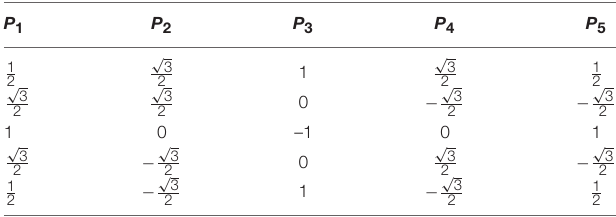
TABLE 1 | An example of a perfect Guttman scale for five items. Response